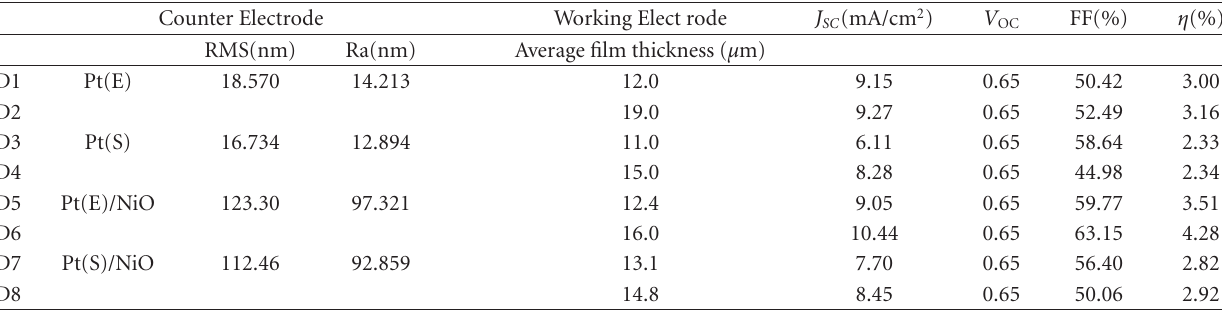
Table 1: Test conditions and power conversion e ffi ciencies of DSSCs. Counter